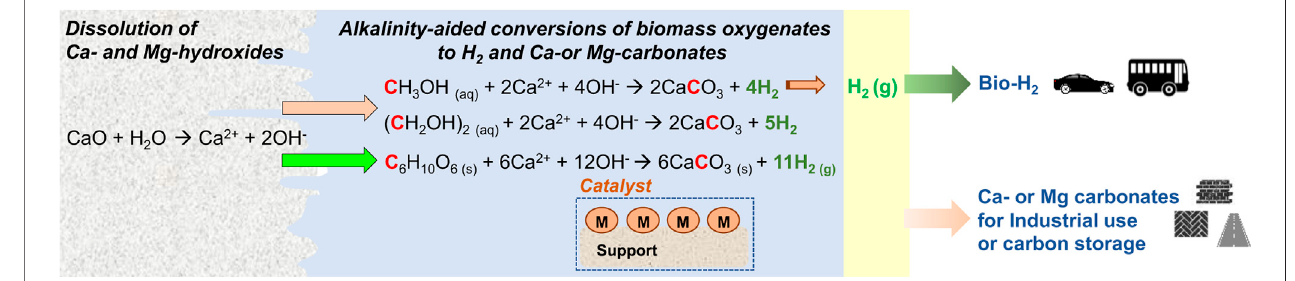
FIGURE 1 | Schematic representation of the multiphase chemical interactions involved in the co-generation of bio-hydrogen and inorganic carbonates from biomass, and alkaline industrial residues or minerals.